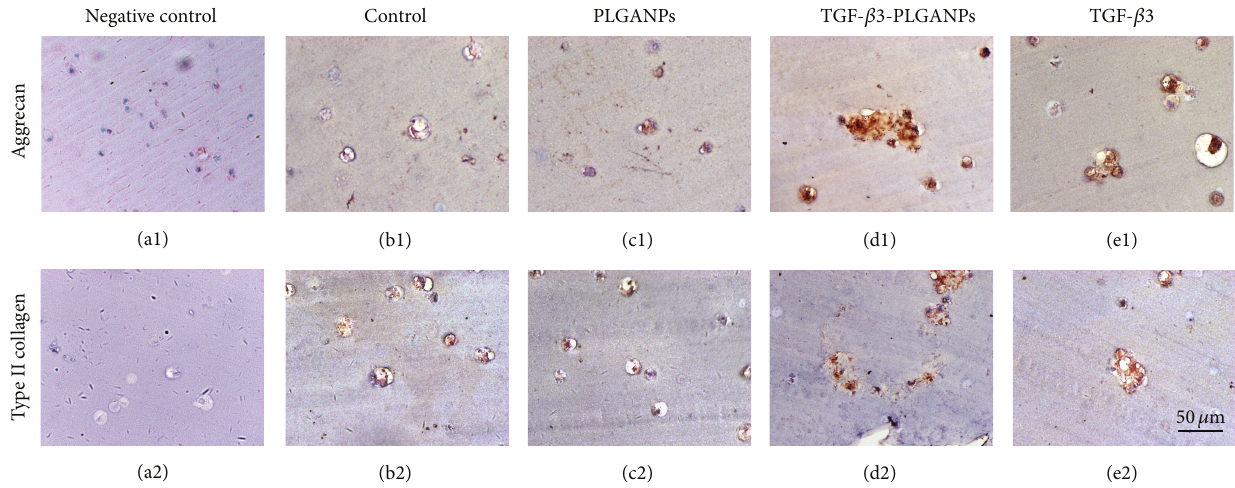
Figure 8: Photomicrographs showed the immunohistological staining for aggrecan (a1–e1) and type II collagen (a2–e2) of neo-NP tissue formation in the codelivery system of the MSCs-seeded dextran/gelatin hydrogel encapsulated with no supplement (control (b1-2)), 1000 𝜇 g/mL blank PLGANPs (PLGANPs (c1-2)), 1000 𝜇 g/mL TGF- 𝛽 3-loaded PLGANPs (TGF- 𝛽 3-PLGANPs (d1-2)), and the hydrogels with no supplements cultured in the medium containing 10ng/mL TGF- 𝛽 3 (TGF- 𝛽 3 (e1-2)) for 28 days. (a1-2) were negative controls for immunostaining (magnification: 400x, scale = 50 𝜇